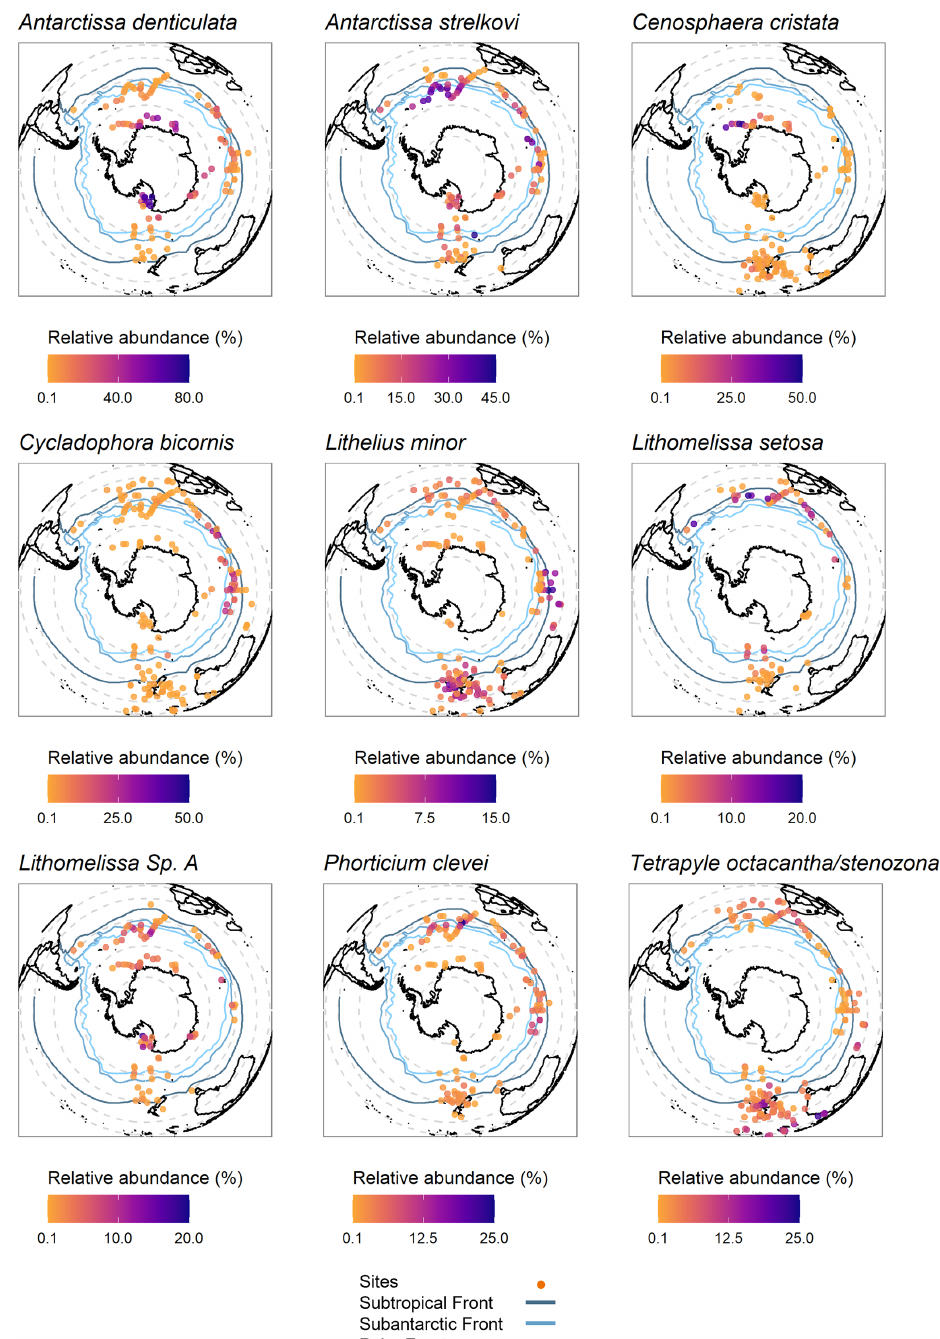
Figure 4. Distribution maps for the nine most abundant and widely distributed radiolarian taxa. Ocean front boundaries from Orsi et al.